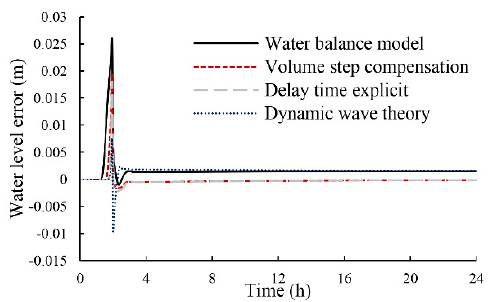
Figure 6. Water level error of downstream control point.